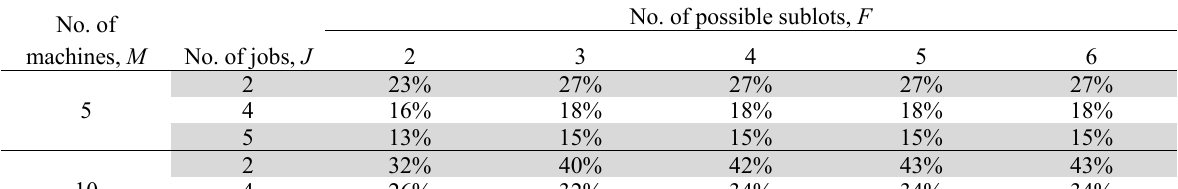
Average relative makespan reduction compared to the no-splitting condition No. of